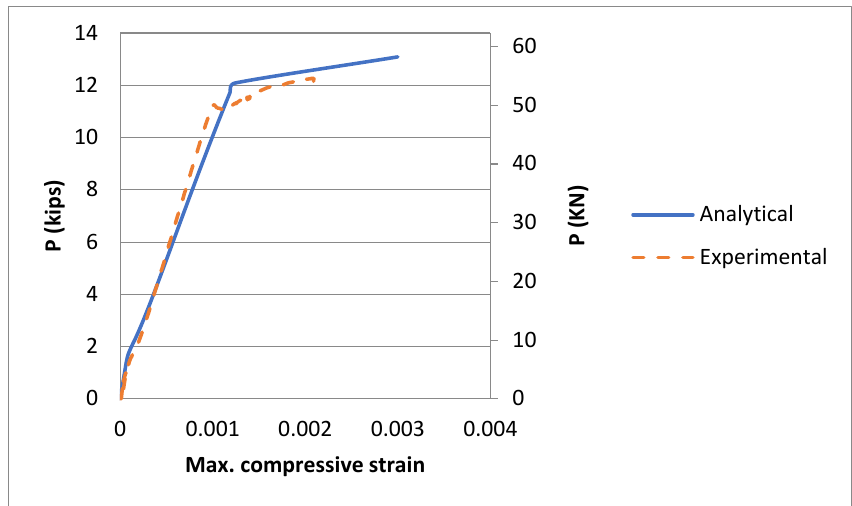
Figure 20. Decker (2007) [18] load vs. tensile steel strain comparison.